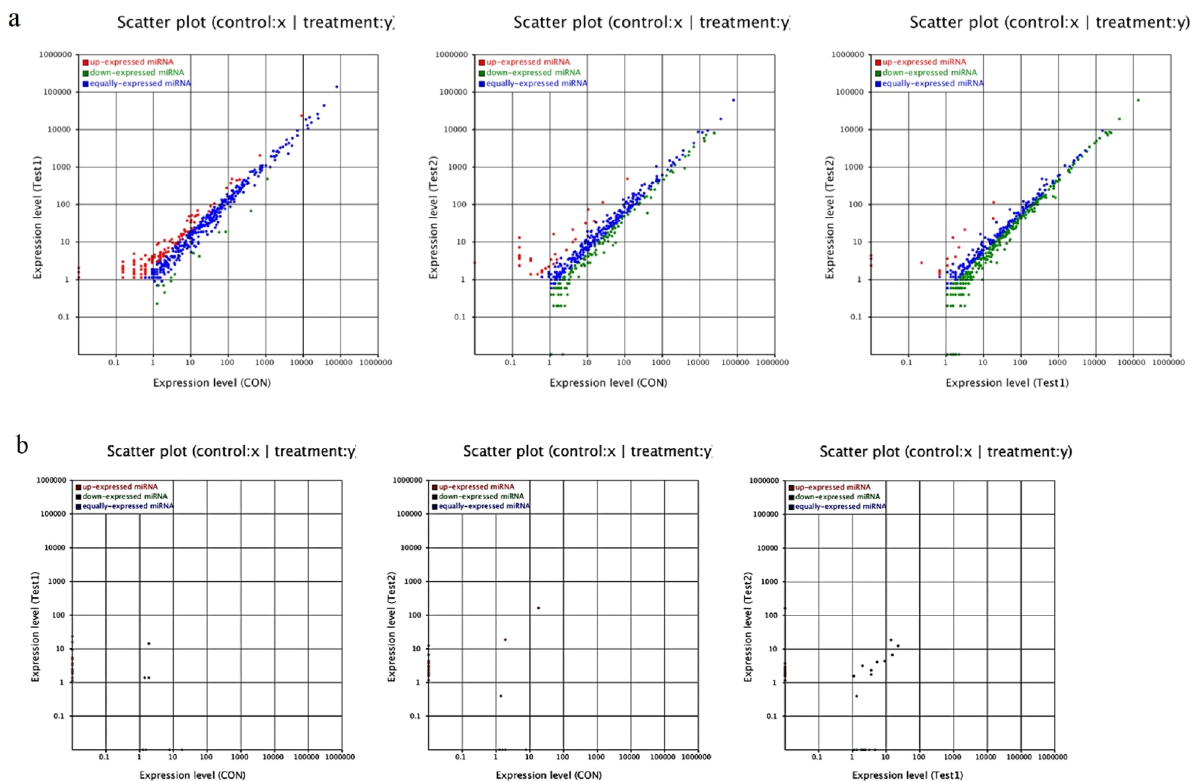
Figure 7. Differential expression patterns of miRNAs between test groups. According to the number of reads counted by high-throughput sequencing, a comparison was drawn between the expression levels of conserved ( a ) and new ( b ) miRNAs at the three libraries. Scatter plots indicate the frequency of conserved and novel miRNAs in Test1 versus Control (left), Test2 versus Control(middle) and Test 2 versus Test 1 (right).